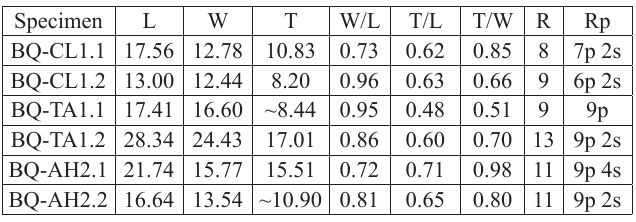
the Talave section. Paratype: DCTMA-BQ-AH2.2 (Figs. 3B, 4, 5). Intraspecific variability is shown through the paratypes (Fig. 3) and measured in Table 1. Table 1. Main biometric measurements (in mm) and ratios of the studied specimens of Misunithyris goyi gen. et sp. nov. L, total length; W, total width; T, total thickness; R, ribs on each valve; Rp, ribbing pattern (p, primary rib; s, secondary rib, referred to bifurcate or intercalated